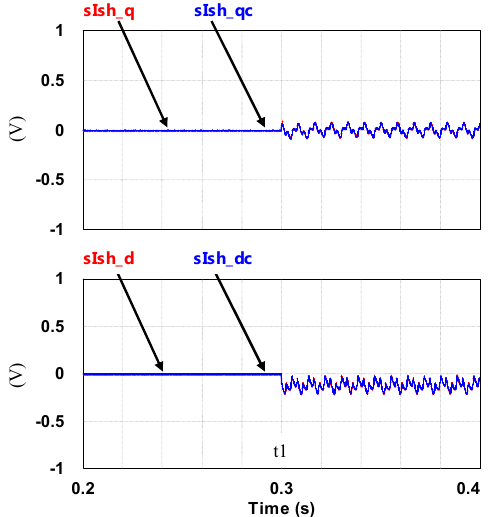
Figure 17. Shunt APF dq-axis current commands and feedbacks (t 0 –t 2 ). Table 2. Root-mean-square (RMS) currents and total harmonic distortion (THD). Power grid currents and unbalance ratio (UR)